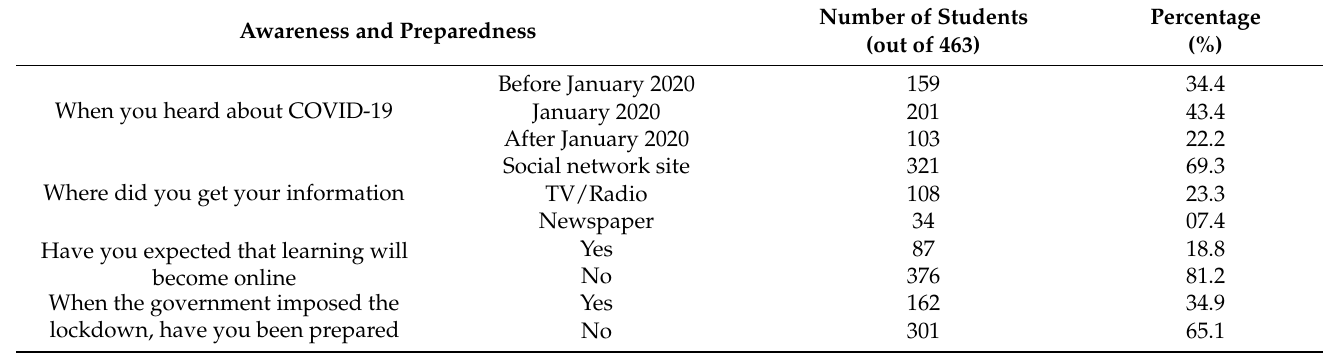
Table 3. Awareness and preparedness for the lockdown.